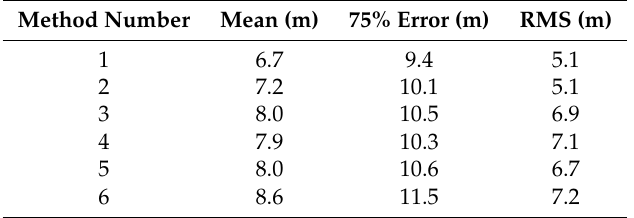
Table 4. The errors for different WLAN positioning methods for Building 2.